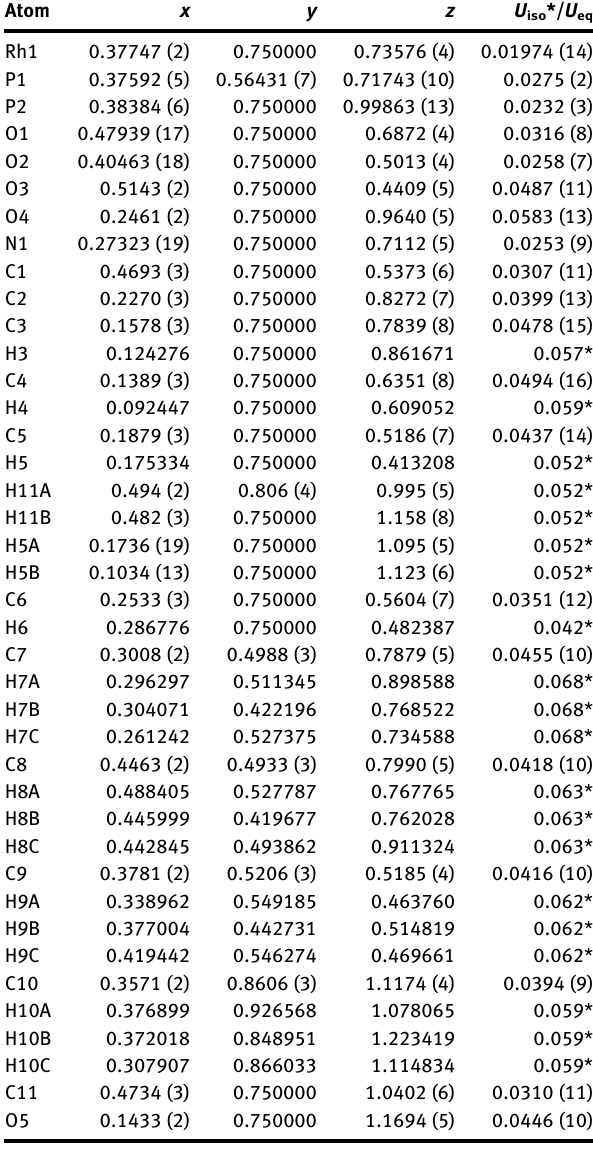
Table  : Fractional atomic coordinates and isotropic or equivalent isotropic displacement parameters (Å 